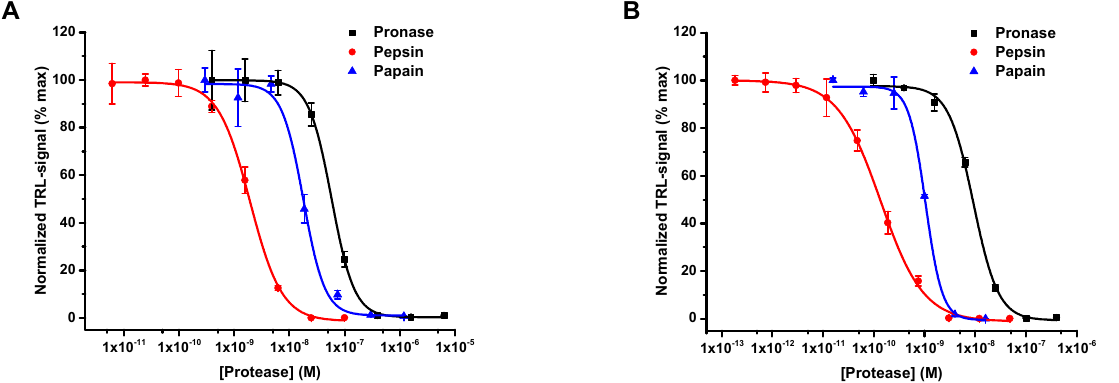
Figure 3. Comparison of native and heat-denatured CA as a substrate for proteases. ( A ) Native CA (100 nM) was used as a digested substrate for pronase (black), pepsin (red), and papain (blue). The EC 50 values were 58.3 ± 1.0, 1.9 ± 0.1, and 16.8 ± 2.0 nM, with the respective S/B ratios from 34 to 114. ( B ) Pronase (black), pepsin (red), and papain (blue) were similarly titrated with heat-denatured CA (3 nM) as the protease substrate. The EC 50 values of 9.2 ± 0.6, 0.14 ± 0.01, and 1.0 ± 0.05 nM were obtained, with S/B ratios from 62 to 117, respectively. In all assays, protease reactions were first incubated for 30 min at 37 °C, before end-point detection using the protein-probe and respective TRL-signal monitoring. Data represent mean ± SD ( n = 3).